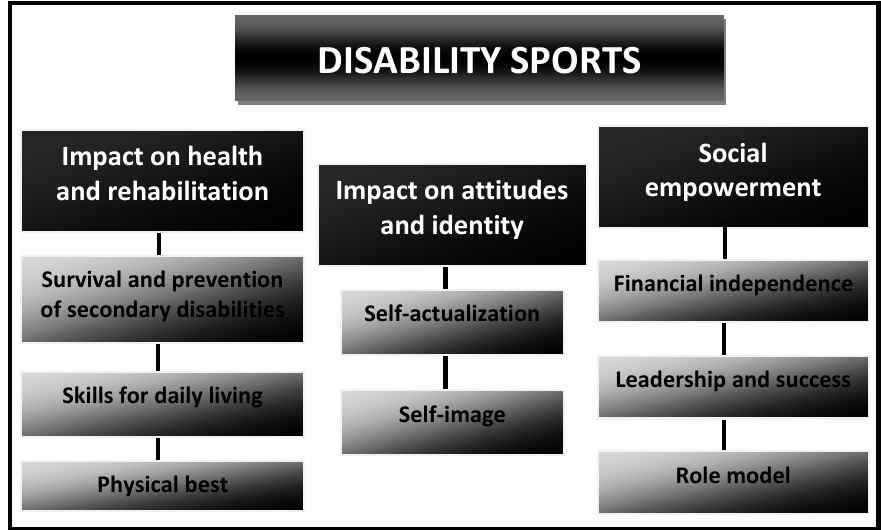
Figure 6. Implications of disability sports in an athlete’s